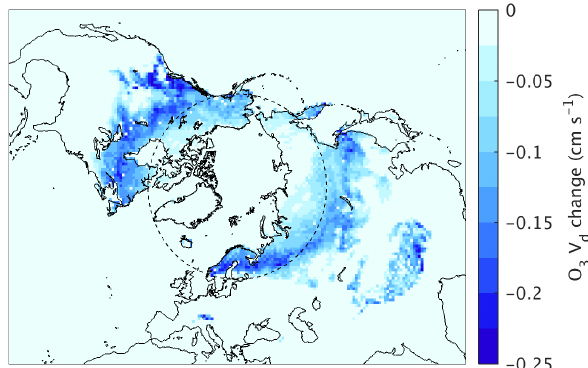
Figure 3. Change in ozone deposition velocity due to the implemen- tation of wintertime dry deposition over seasonal snow (April 2008 average, ALL_UPDATES –